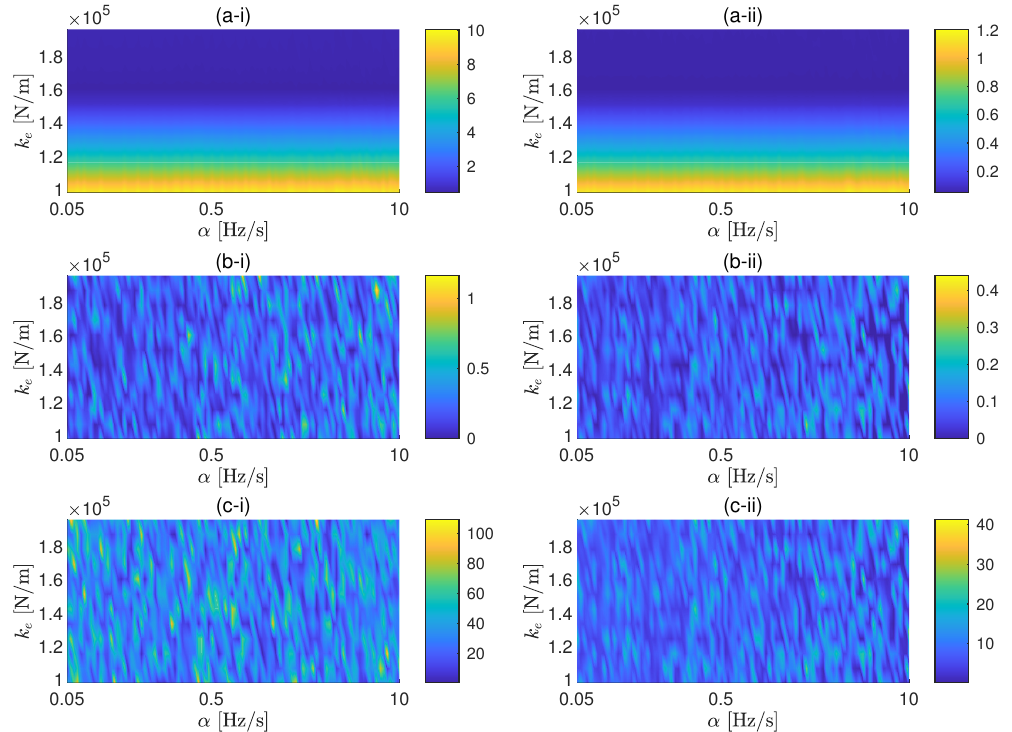
Figure 8. General ( a ), resonance frequency ( b ) and resonance amplitude ( c ) errors as a function of the sweep rates and the dynamic stiffness of the spring for excitation force amplitudes of 2.5 N (i) and 25 N (ii). Background noise: 3.3 × 10 − 8 m/s 2